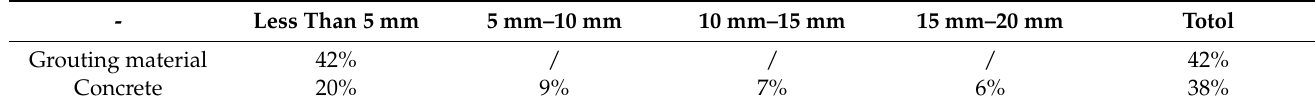
Table 5. The volume of aggregate in HSGM and concrete.